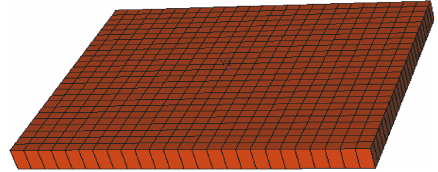
Figure 5: The schematic for the simulation model.